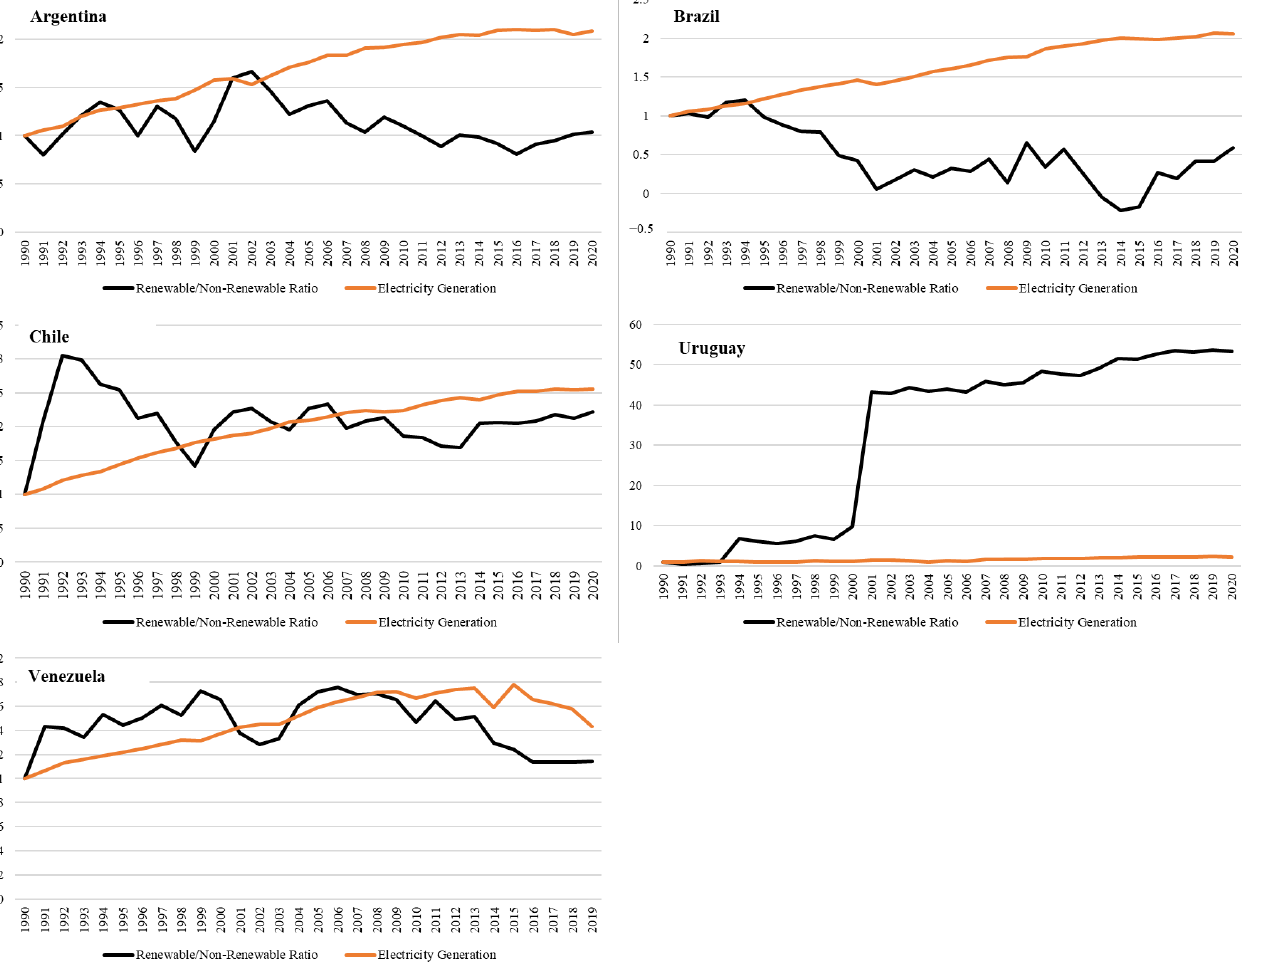
Figure 7. Analyses of the cumulative variation of renewable/non-renewable ratio and electricity generation of Argentina, Brazil, Chile, Uruguay, and Venezuela. Source: Elaborated by the authors based on [38 – 40].